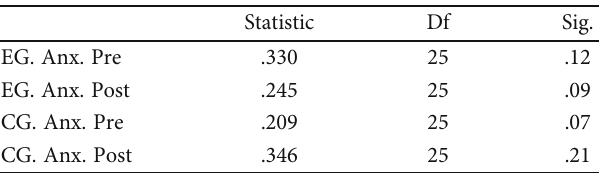
Table 7: One-sample Kolmogorov-Smirnov test (foreign language anxiety).